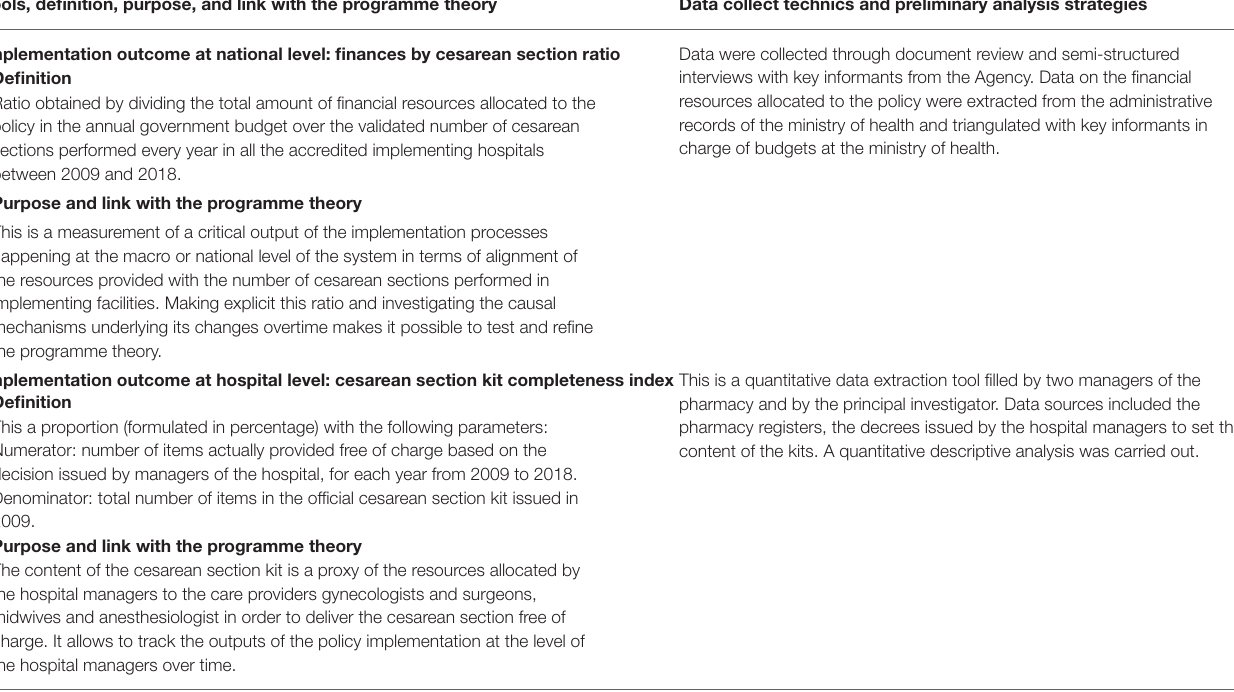
TABLE 2 | Tools to assess the policy outcome at various levels: definition, purposes, link with the programme theory, data collection technics, and preliminary analysis